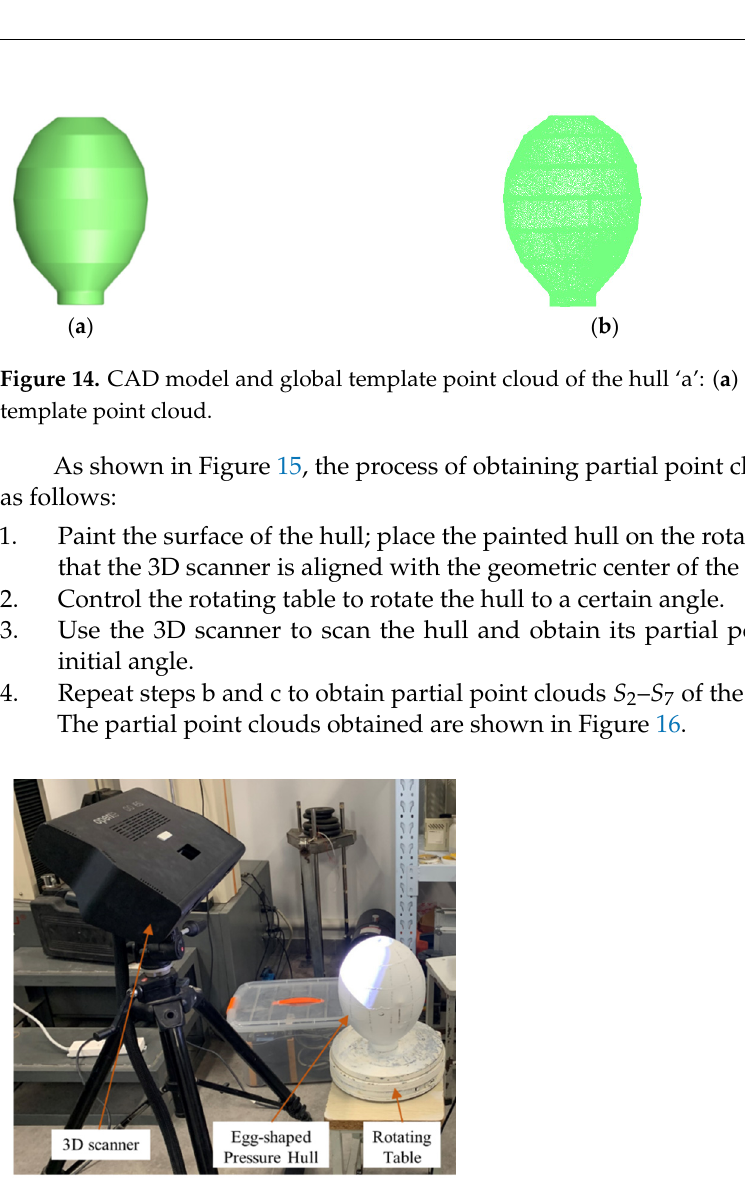
Figure 15. Scanning scene photo of the hull ‘a’ to obtain partial point clouds.